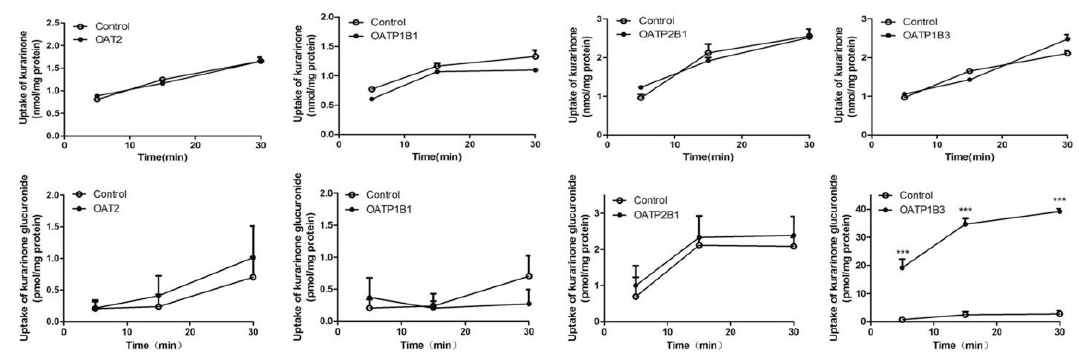
Figure 9. Time courses of uptake of kurarinone and kurarinone glucuronide by OAT2-, OATP1B1-, OATP2B1-, and OATP1B3- transfected HEK293 cells. (mean ± S.D., n = 3). *** p < 0.001 versus control.